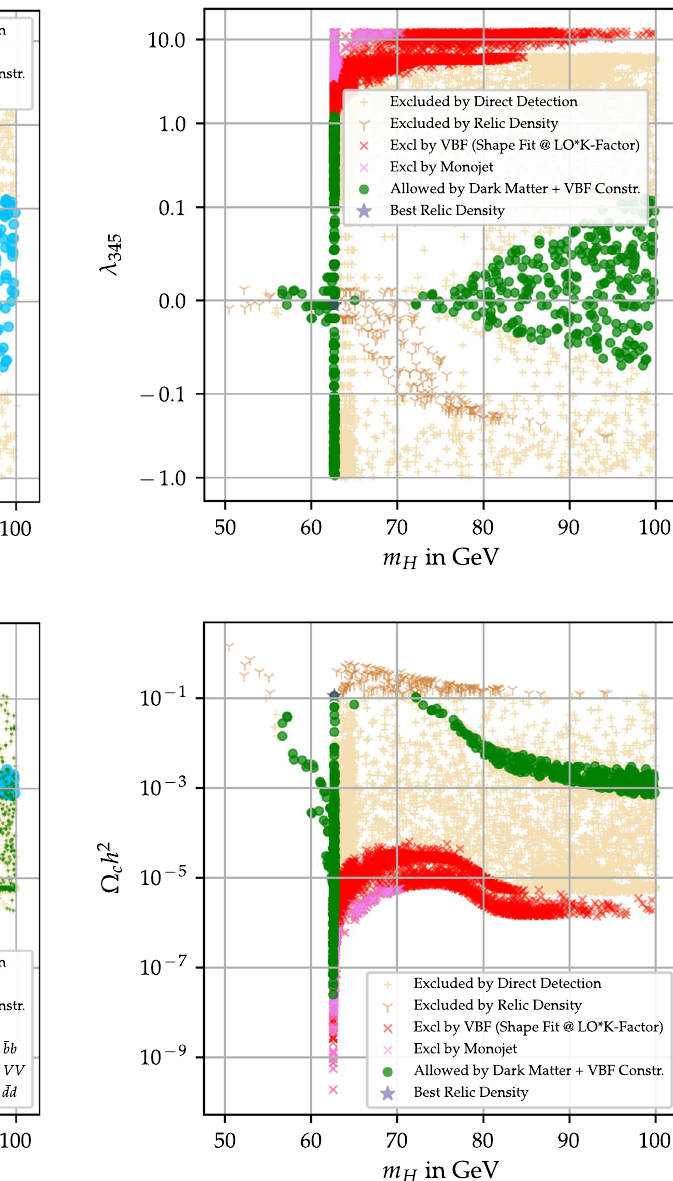
Fig. 4 Parameter space after including all constraints (see also expla- nations below Fig. ,Ω 2 ) plane. On H c h